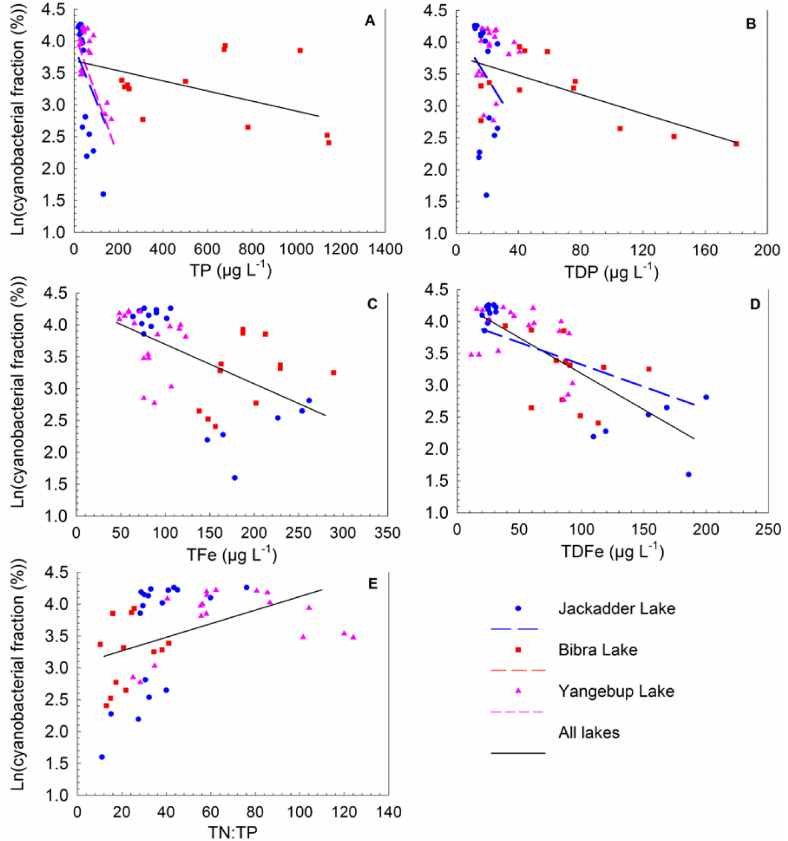
Figure 6. The correlations between cyanobacterial fraction and (a) TP, (b) TDP, (c) TFe, (d) TDFe, (e) TN:TP in Jackadder, Bibra and Yangebup lakes during the study period. Regression curves for each individual lake were calculated by linear mixed models with site and date as random factors on data from each lake (broken lines) while all data points were combined for the overall regression using a linear mixed model adding lake as random factor (solid line). Only significant ( p < 0.05) regressions are shown. Table 2. Pearson’s correlation coefficients ( R ) between the environmental factors and cyanobacterial fraction (%) or cyanobacterial biomass (µgchl a L − 1 ) analysed for each lake and for all lakes combined using bivariate correlation analysis. The dependent variables are ln trans- formed.